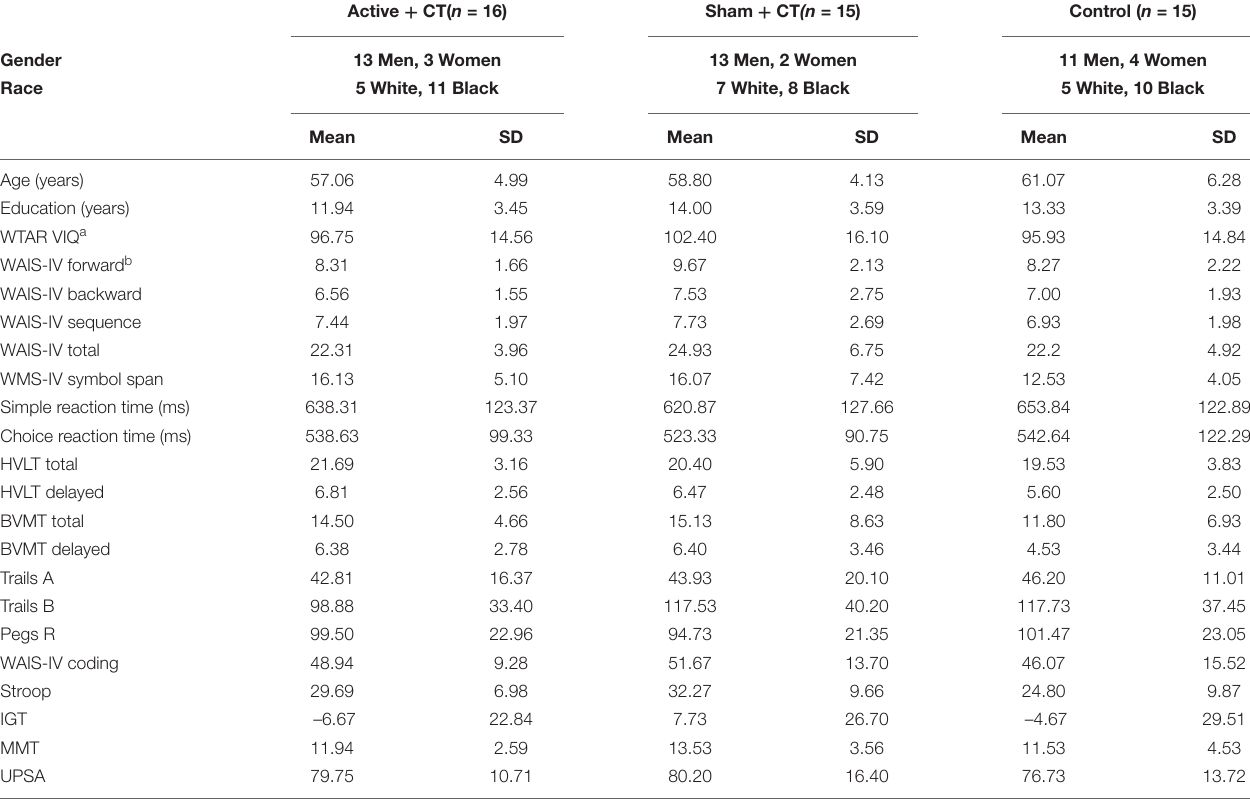
TABLE 2 | Baseline characteristics of treatment